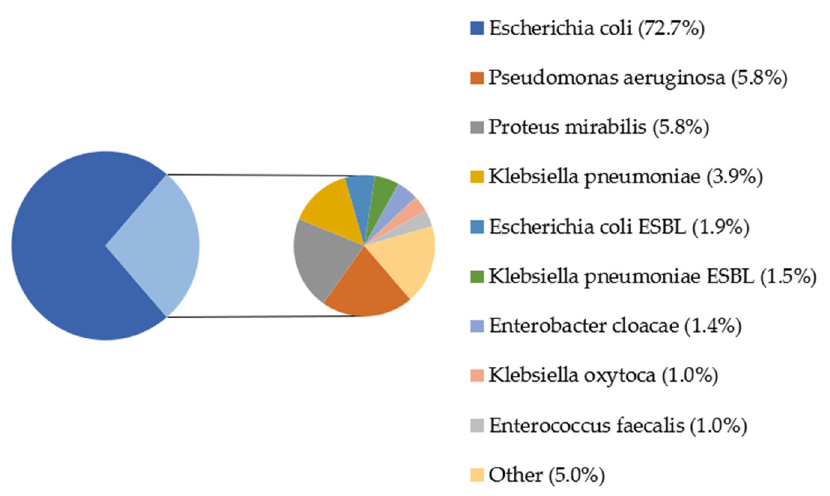
Figure 2. Percentage of leukocyturia in studied urine samples.